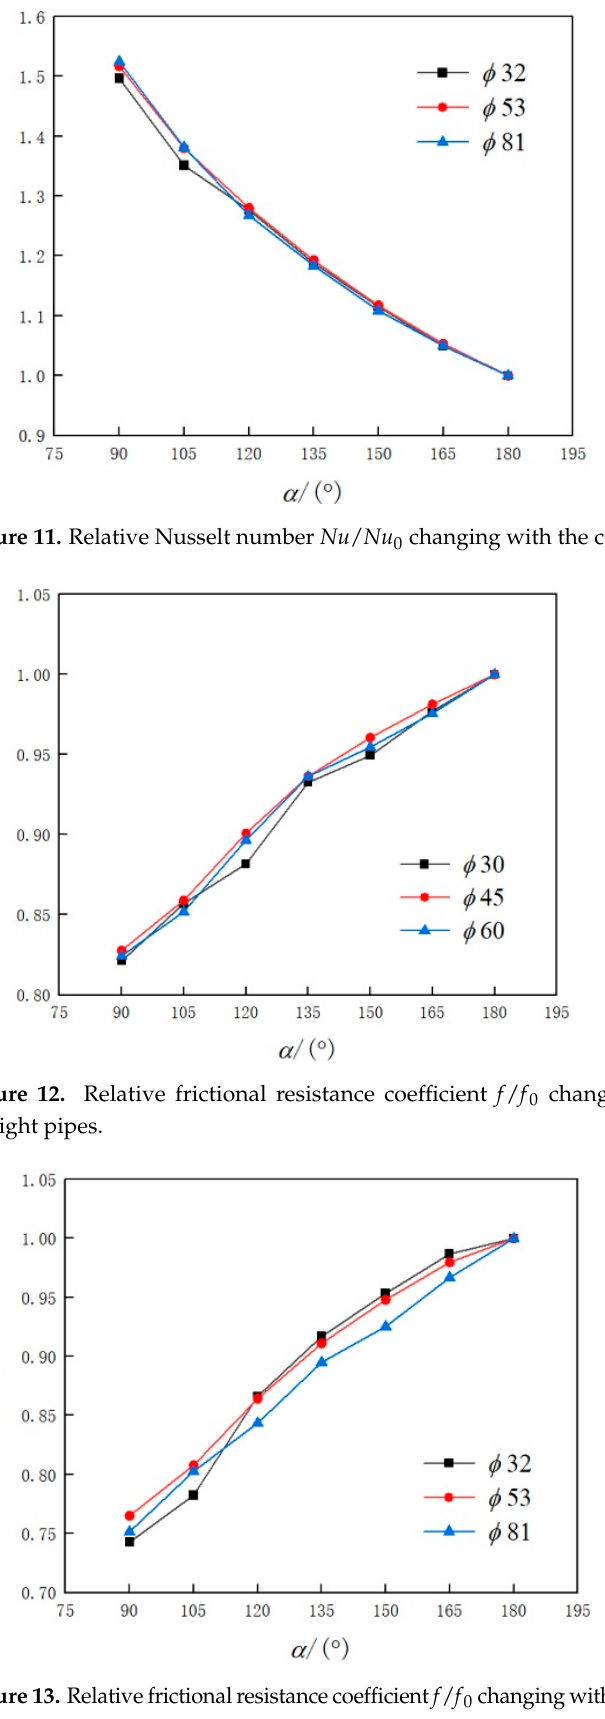
Figure 14. Comprehensive performance evaluation factor pec changing with the central angle α for straight pipes. Figure 15. Comprehensive performance evaluation factor pec changing with the central angle α for helical pipes.